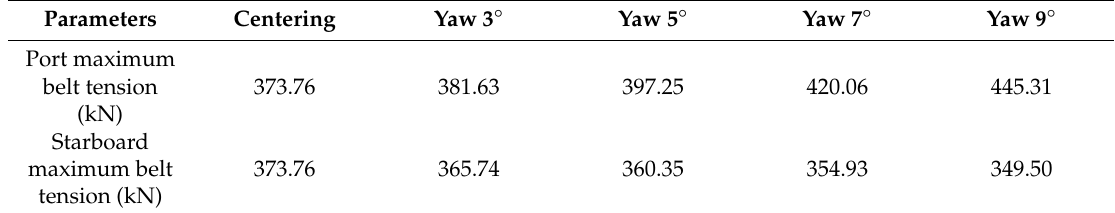
Table 3. Comparison of the port and starboard maximum belt tensions of di ff erent eccentricity.